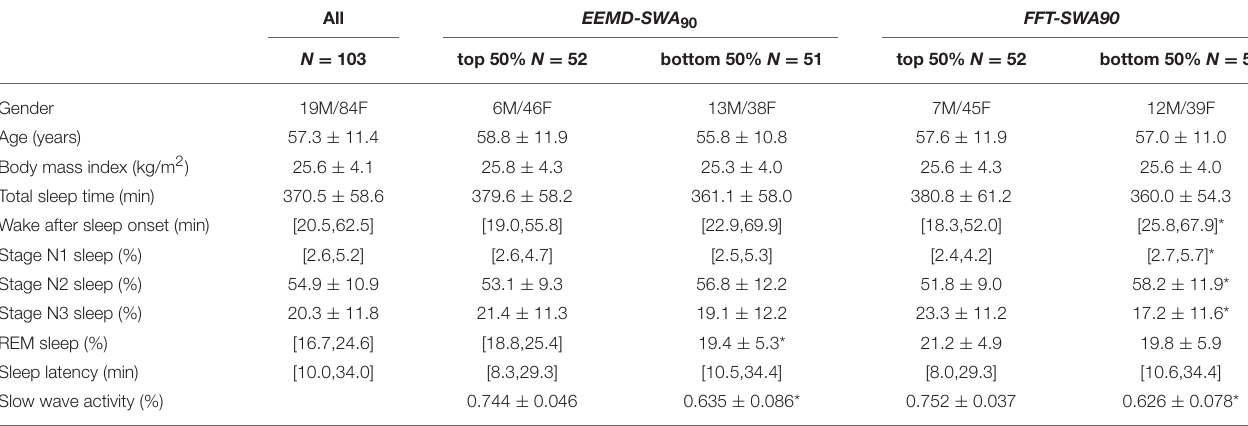
TABLE 2 | Demographics and sleep variables derived from visual scoring.